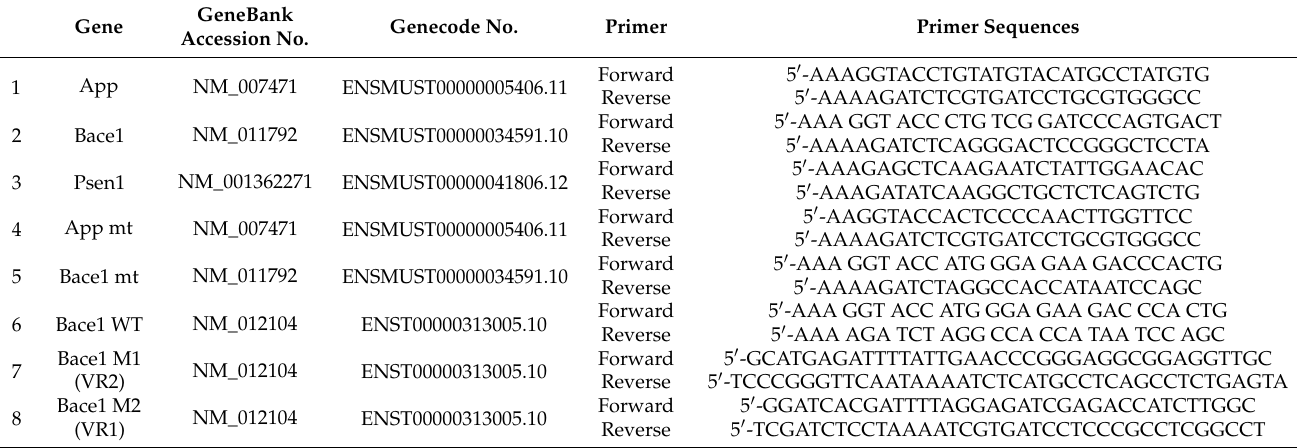
Table A2. The cloning primer information used for luciferase reporter assays in this study (Figures 3c–e, 4g,h and